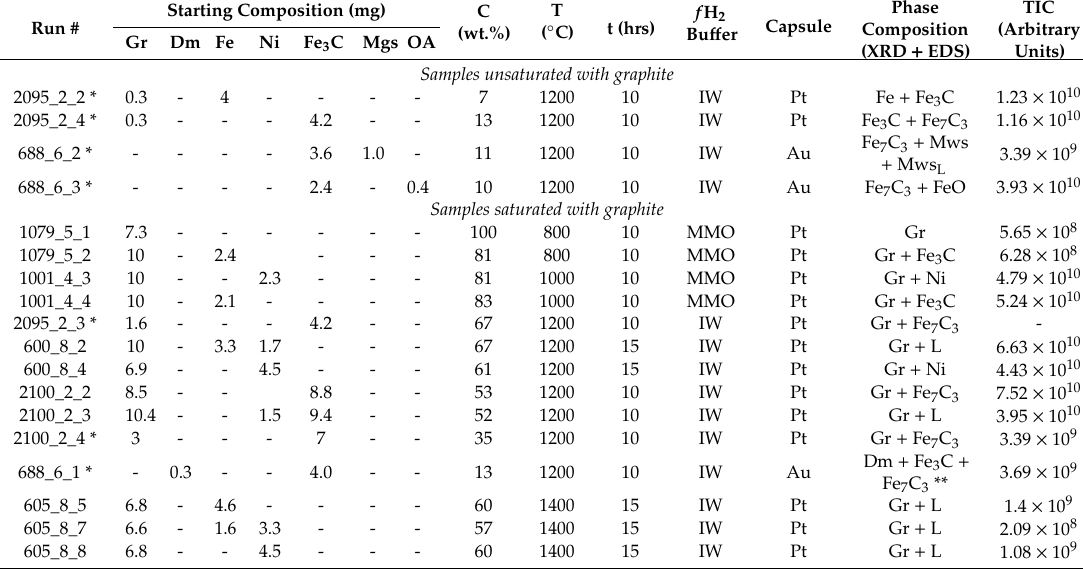
Table 1. Starting compositions and conditions of 6.3 GPa runs and phase compositions of run products (according to X-ray di ff raction analysis and EDS